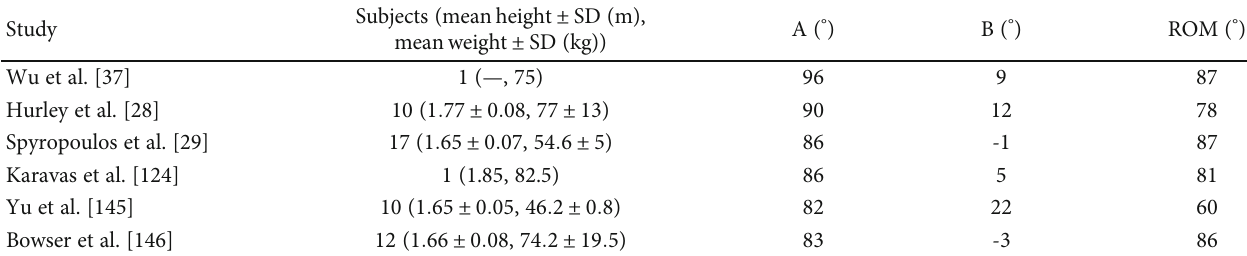
Table 10: Overview over the experimental results of knee angle for sit-to-stand.